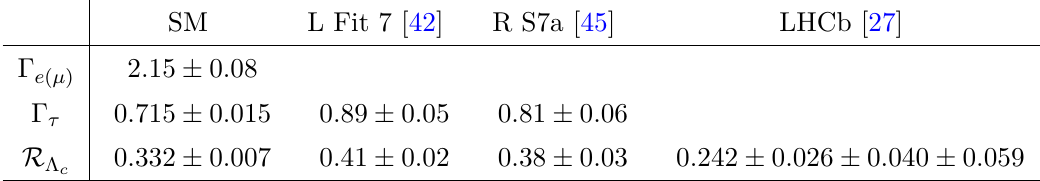
(cid:0) = Γ Λ b → Λ c e ( µ )¯ ν e ( µ )